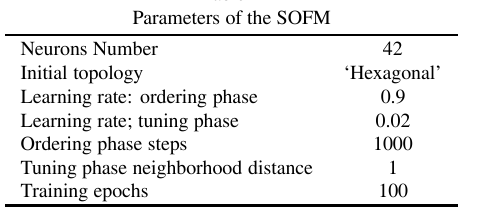
Table 4 Parameters of the SOFM Neurons